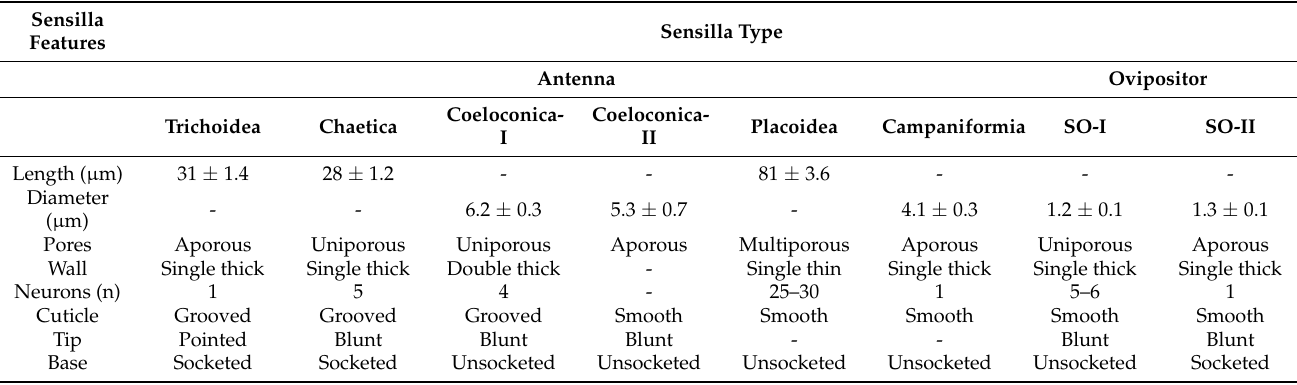
Table 1. Morphological features of the antennal and ovipositor sensilla in Dryocosmus kuriphilus female (mean ± SE). Sensilla